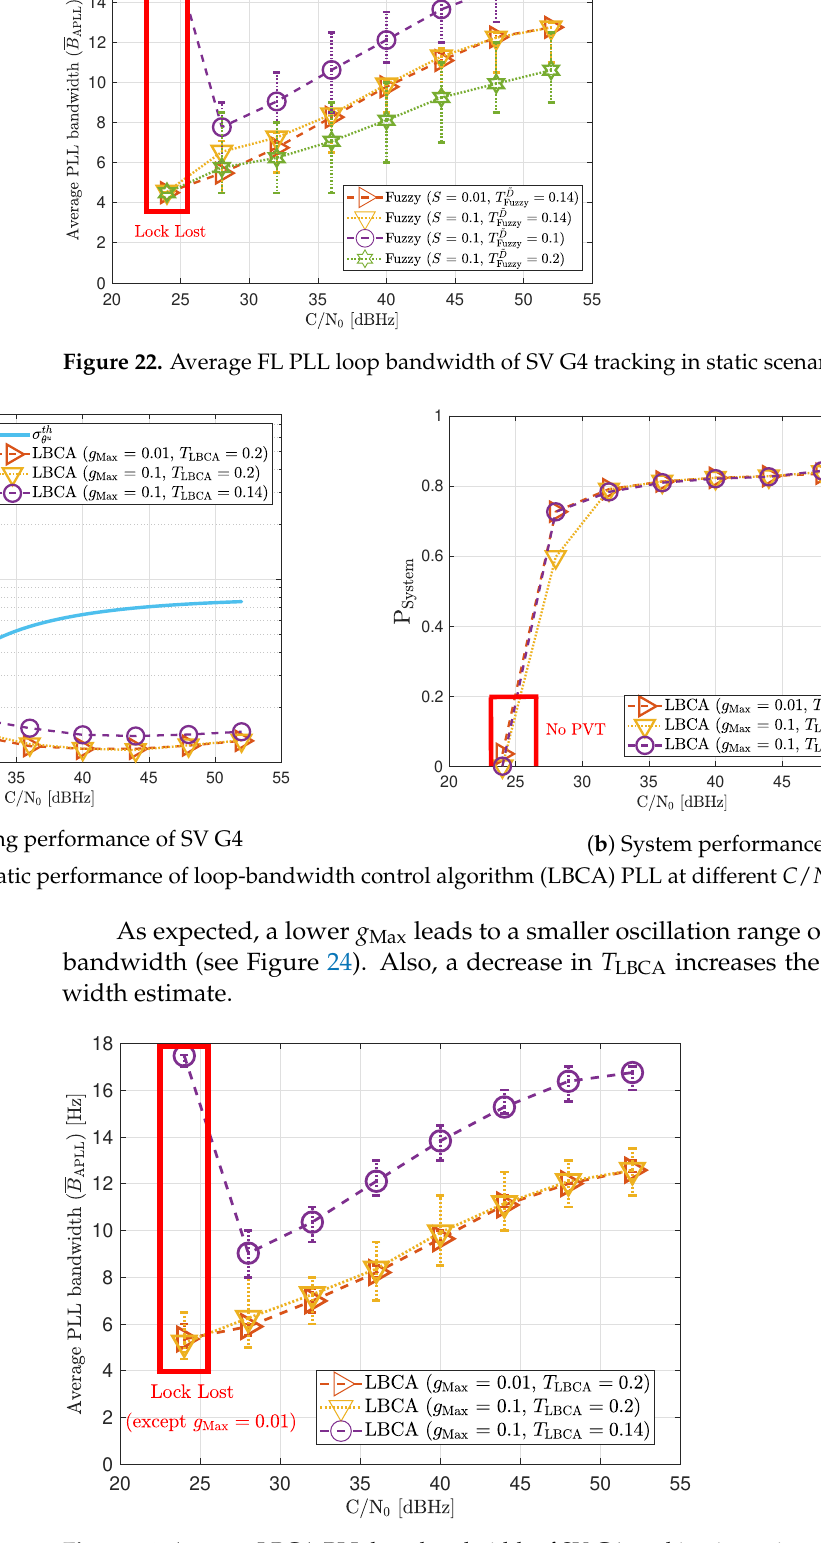
Figure 24. Average LBCA PLL loop bandwidth of SV G4 tracking in static